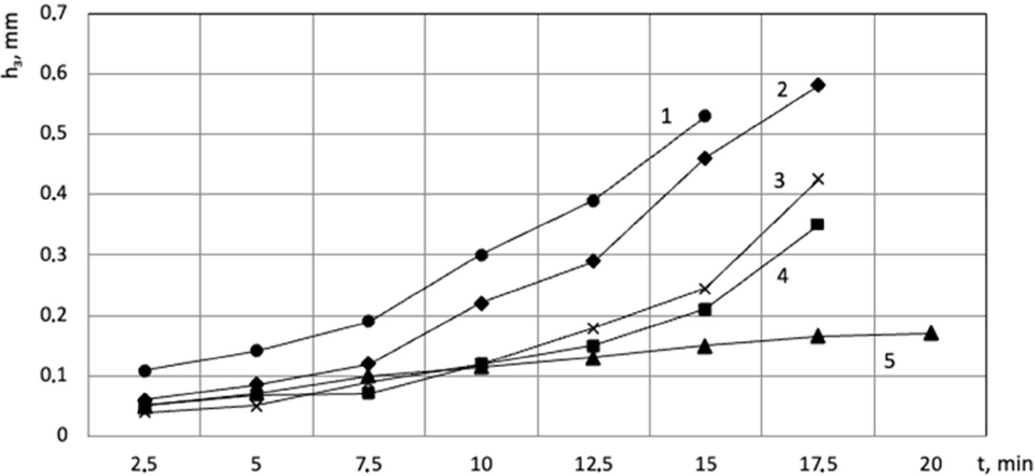
Figure 6. Graph of the dependency of flank wear land vs. the rake angle of the cutter: 1— γ = 12°; 2— γ = − 7°; 3— γ = 8°; 4— γ = 0°; 5— γ = 4°.